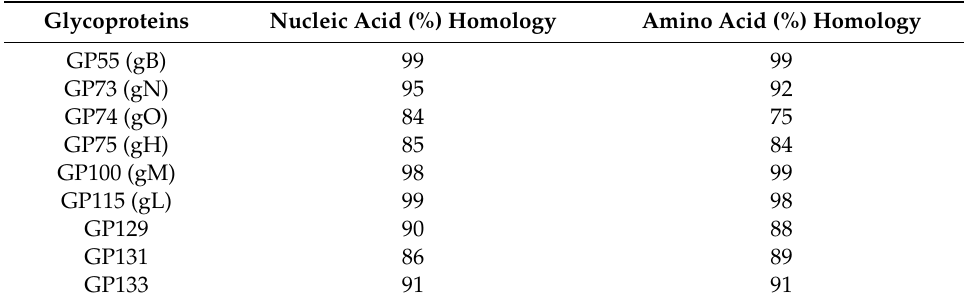
Table 1. Nucleic acid and amino acid homology comparison between guinea pig cytomegalovirus (GPCMV) TAMYC and 22122 strains.